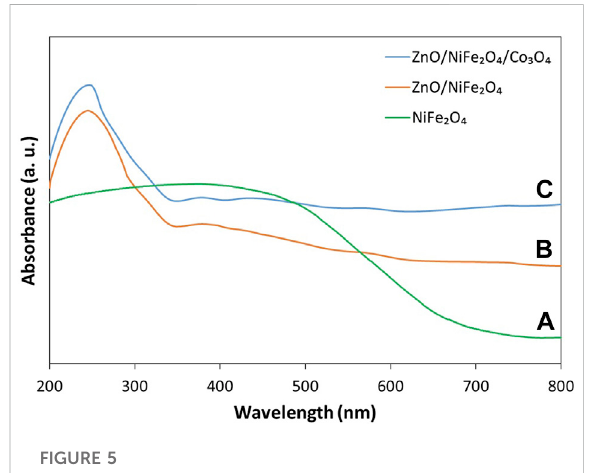
FIGURE 6 Tauc plot of (A) NiFe 2 O 4 , (B) ZnO/NiFe 2 O 4 and (C) ZnO/ NiFe 2 O 4 /Co 3 O 4